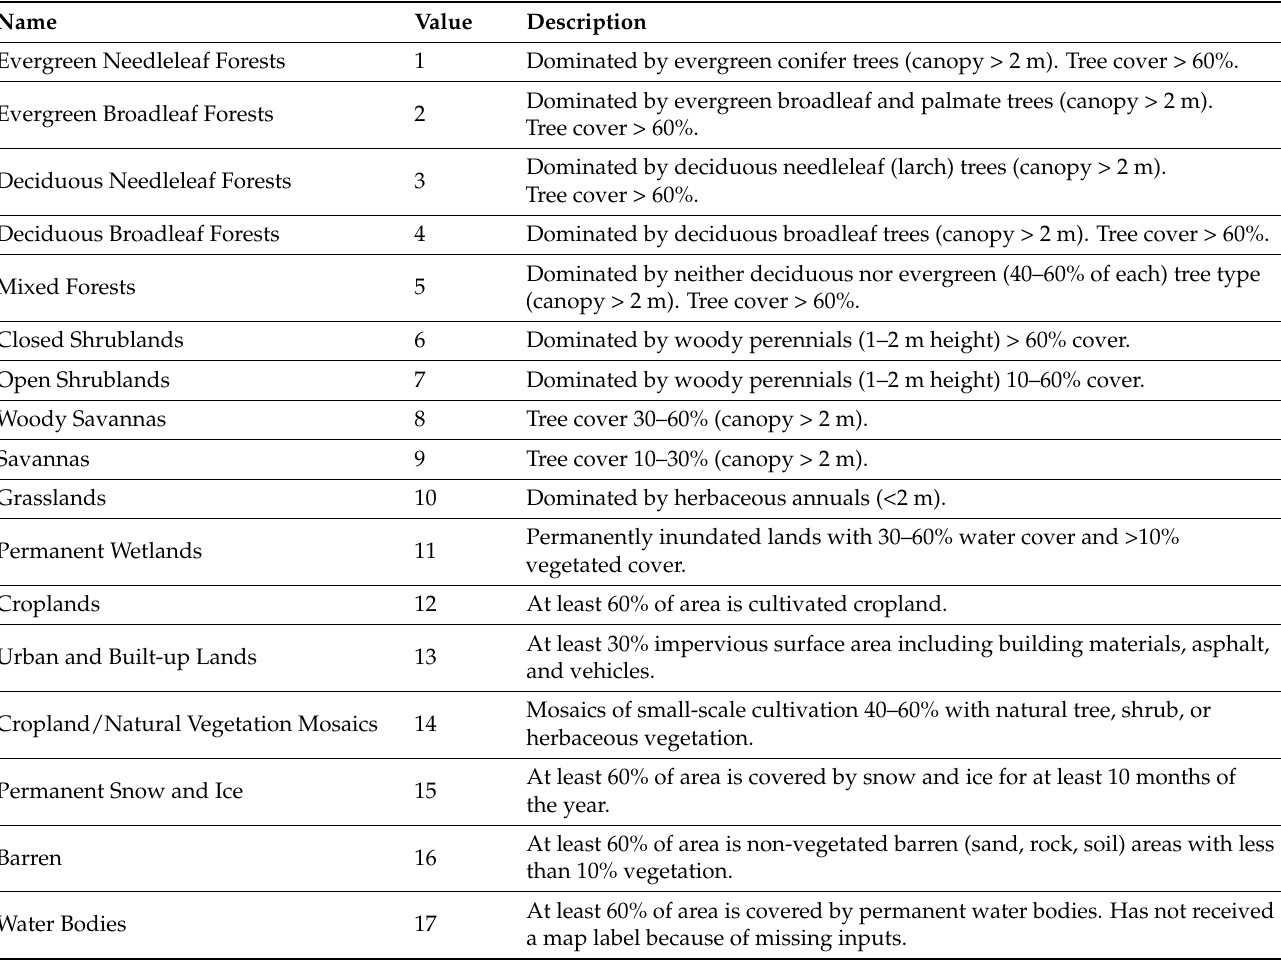
Table 2. IGBP land cover types.